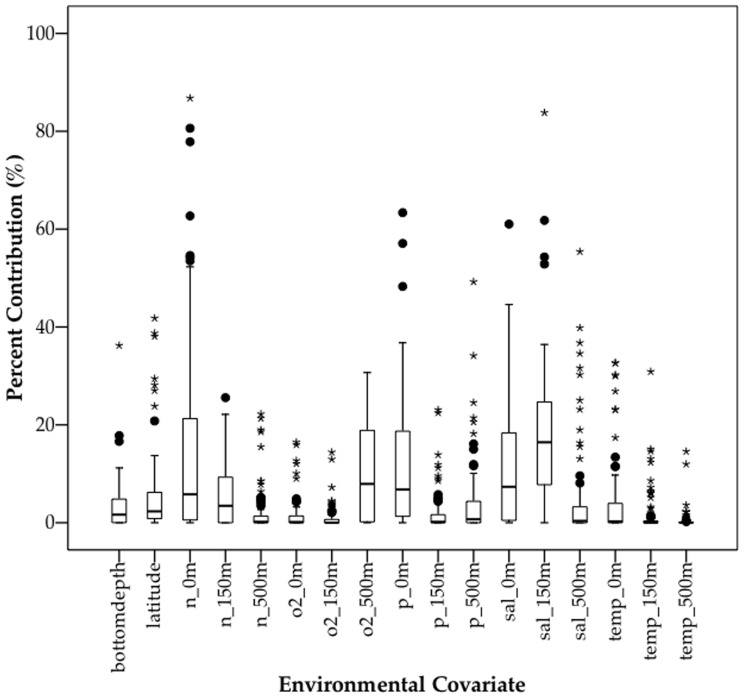
Boxplot summary of percentage contribution of environmental covariates to MAXENT species-habitat models for 95 lanternfish species.Three depth strata (0 m, 150 m and 500 m) tested for variables nitrate (n), phosphate (P), oxygen (O2), salinity (sal) and temperature (temp). Boxes represent median and interquartile range, whiskers span data range, black circles represent outliers and stars represent extreme values.